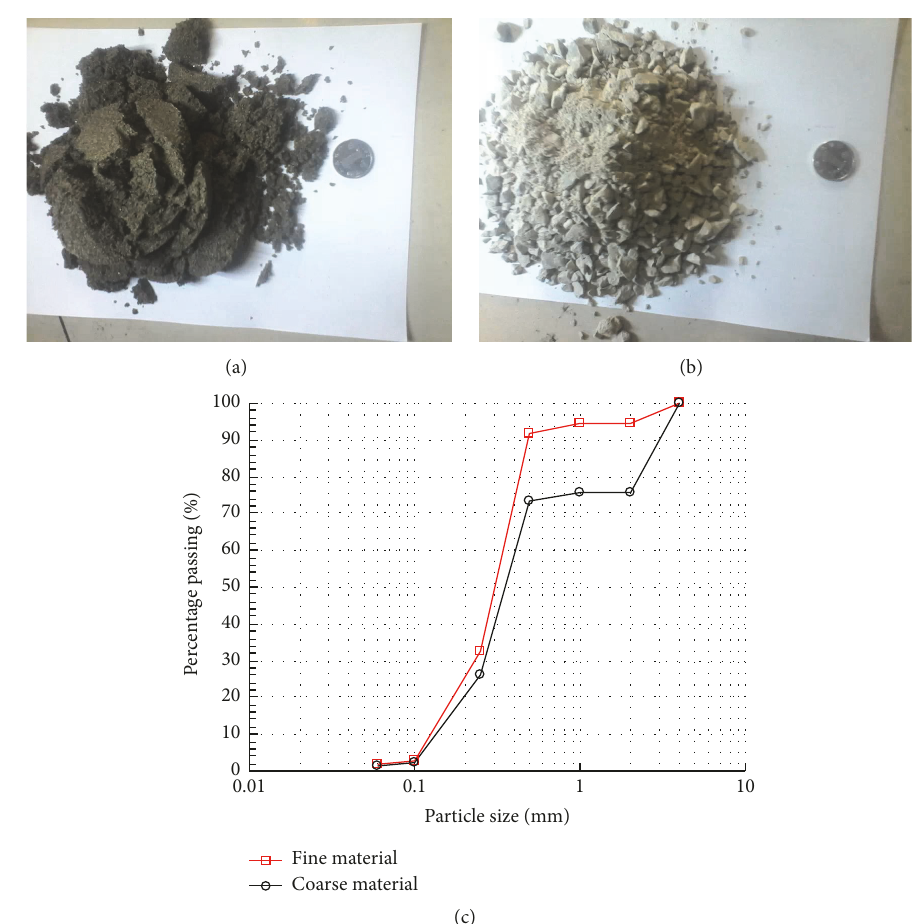
Figure 4: Schematic diagram of modified tank model system: (a) fine material; (b) coarse material; (c) particle-size distribution